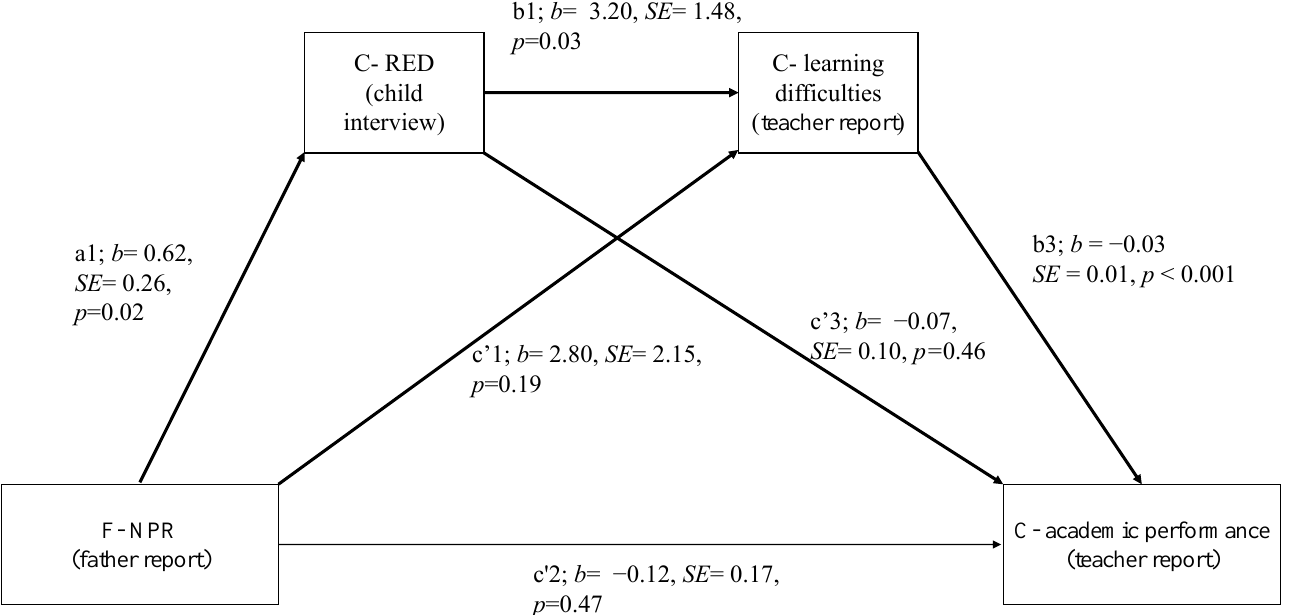
Figure 2. Mediation analysis: The association between father’s negative perception of relationships with the child (NPR) and the teacher’s report on child’s learning difficulties or academic performance ( b ) are mediating by the child’s aggressive response and evaluation decision (C-RED). a1 = the link between F-NPR and child’s RED. b1 = the link between child’s RED and child’s learning difficulties. b3 = the association between child’s learning difficulties and child’s academic performance. c’1 = the association between F-NPR and child’s learning difficulties. c’2 = the association between F-NPR and child’s learning difficulties. c’3 = the association between child’s RED and child’s academic performance. Unstandardized coefficients are reported. SE = Standard error; p = p values. Significant indirect effects are in